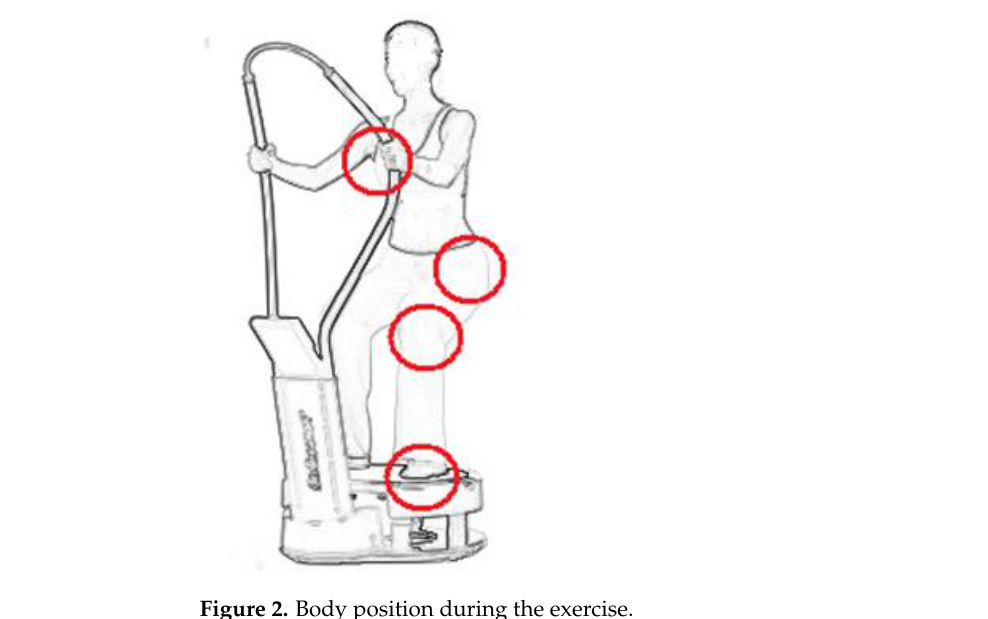
Figure 2. Body position during the